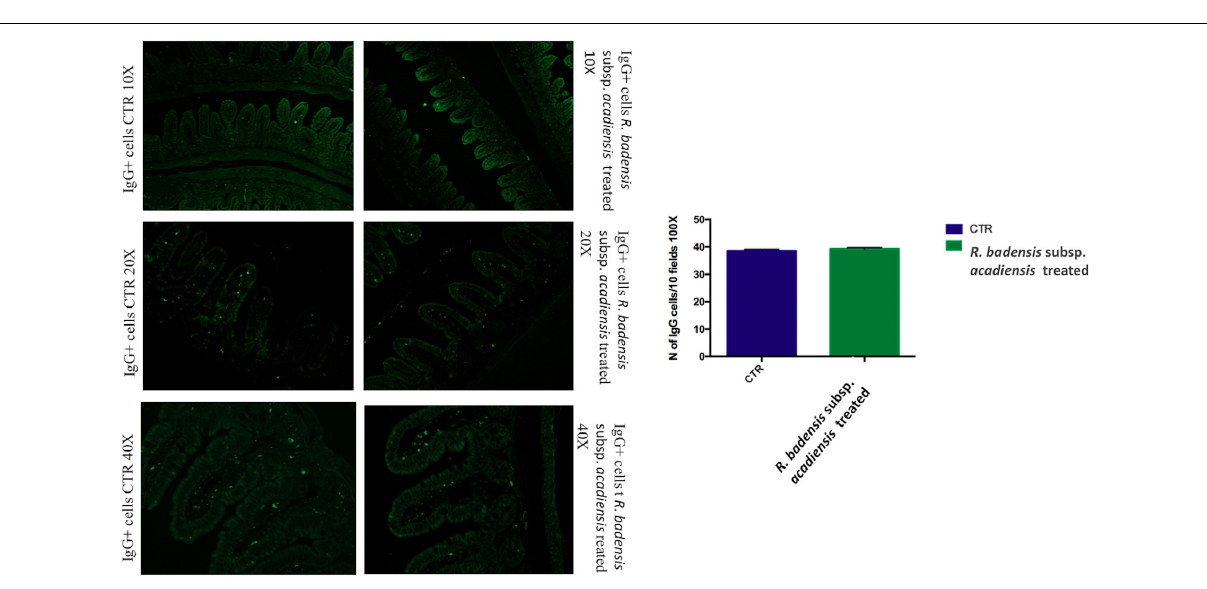
FIGURE 4 | Mean ± SEM of the number of IgG positive cells populations in 10 fields of objective 100X in the ileum of mice fed 1% sucrose (CTR) or R. badensis subsp. acadiensis fed 10 8 CFU/mouse/day for 7 days. Significant difference exists if * p < 0.05, representative tissue photos are taken with 10 × , 20 × , and 40 ×